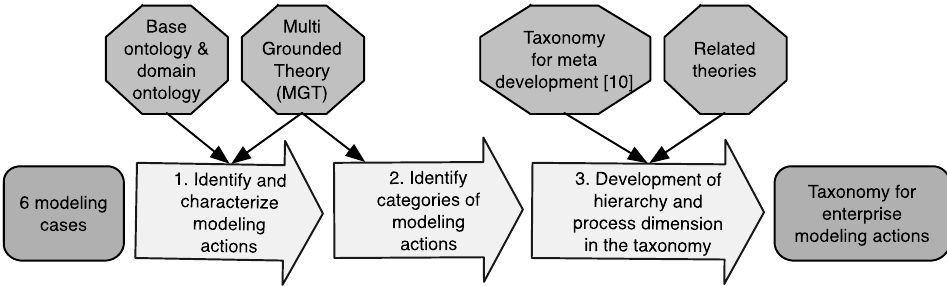
Figure 1 . Research process for development of the